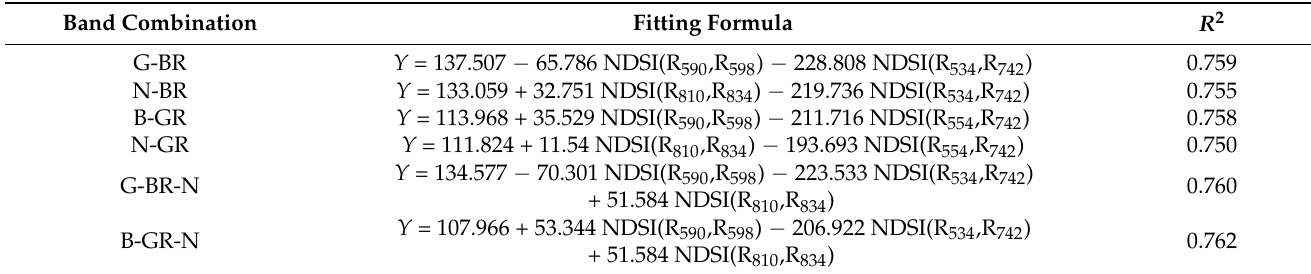
Table 4. Optimal band combinations and fitting formulas.